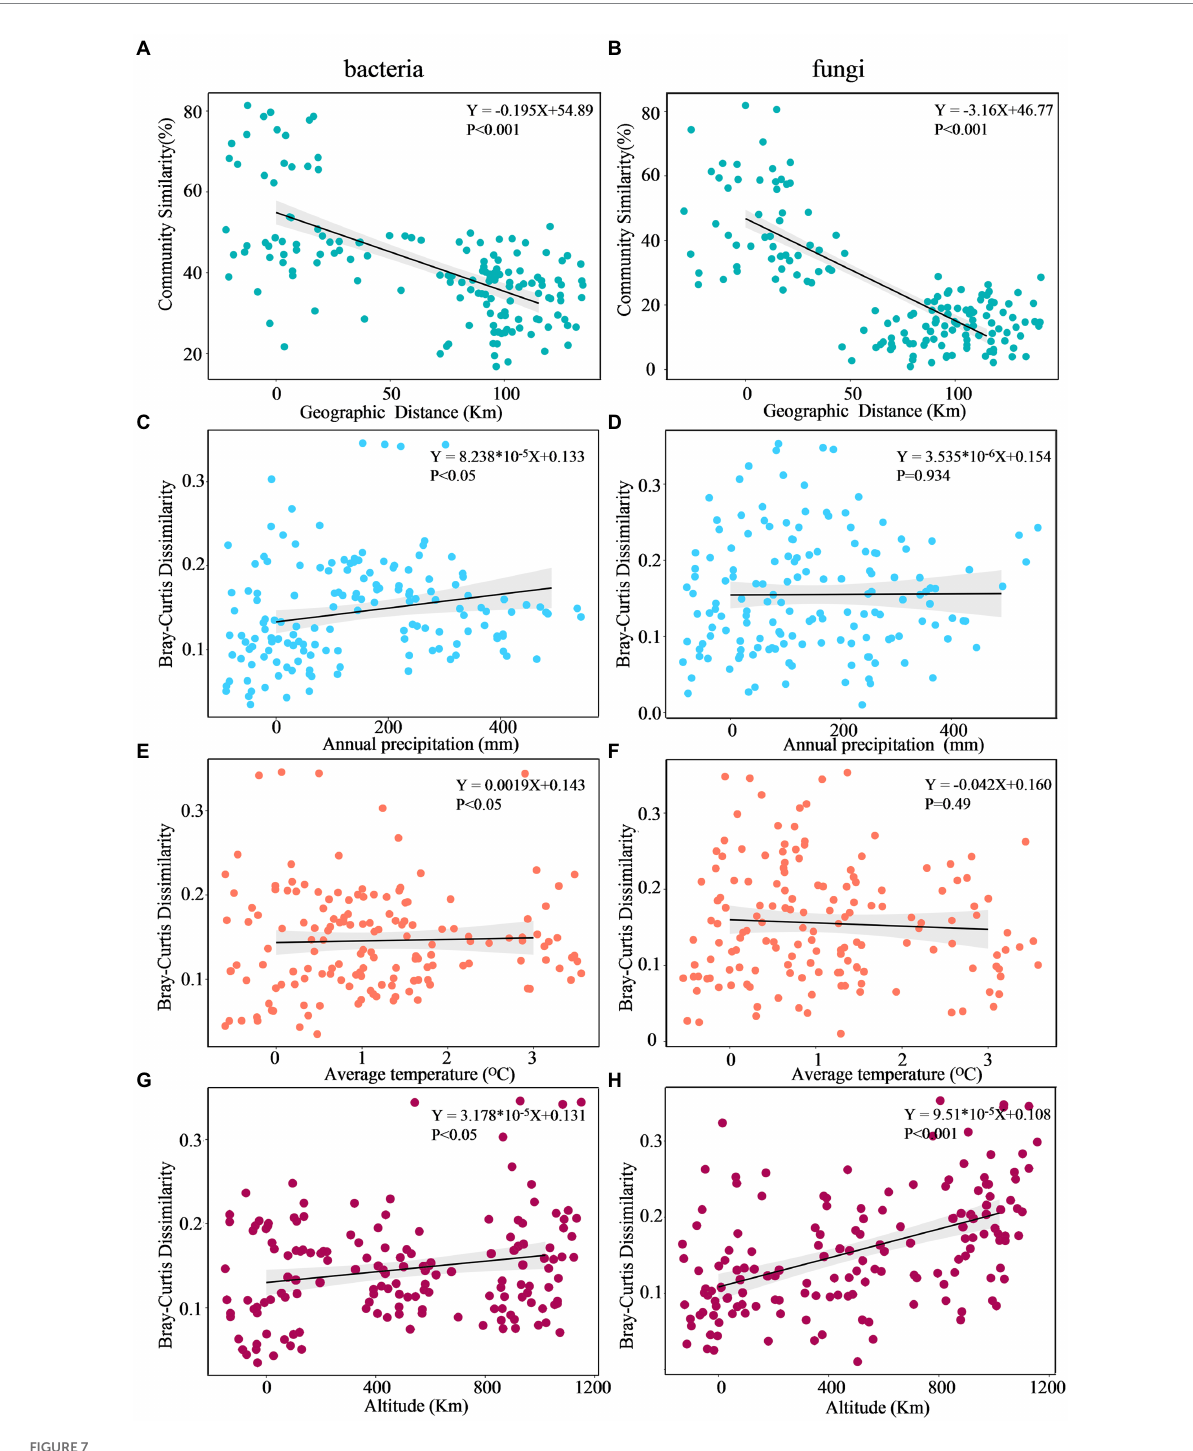
FIGURE 7 Multiple regression analysis of microbial community DDR across Euclidean distance (A,B) , annual precipitation (C,D) , average temperature (E,F) , and altitude (G,H)